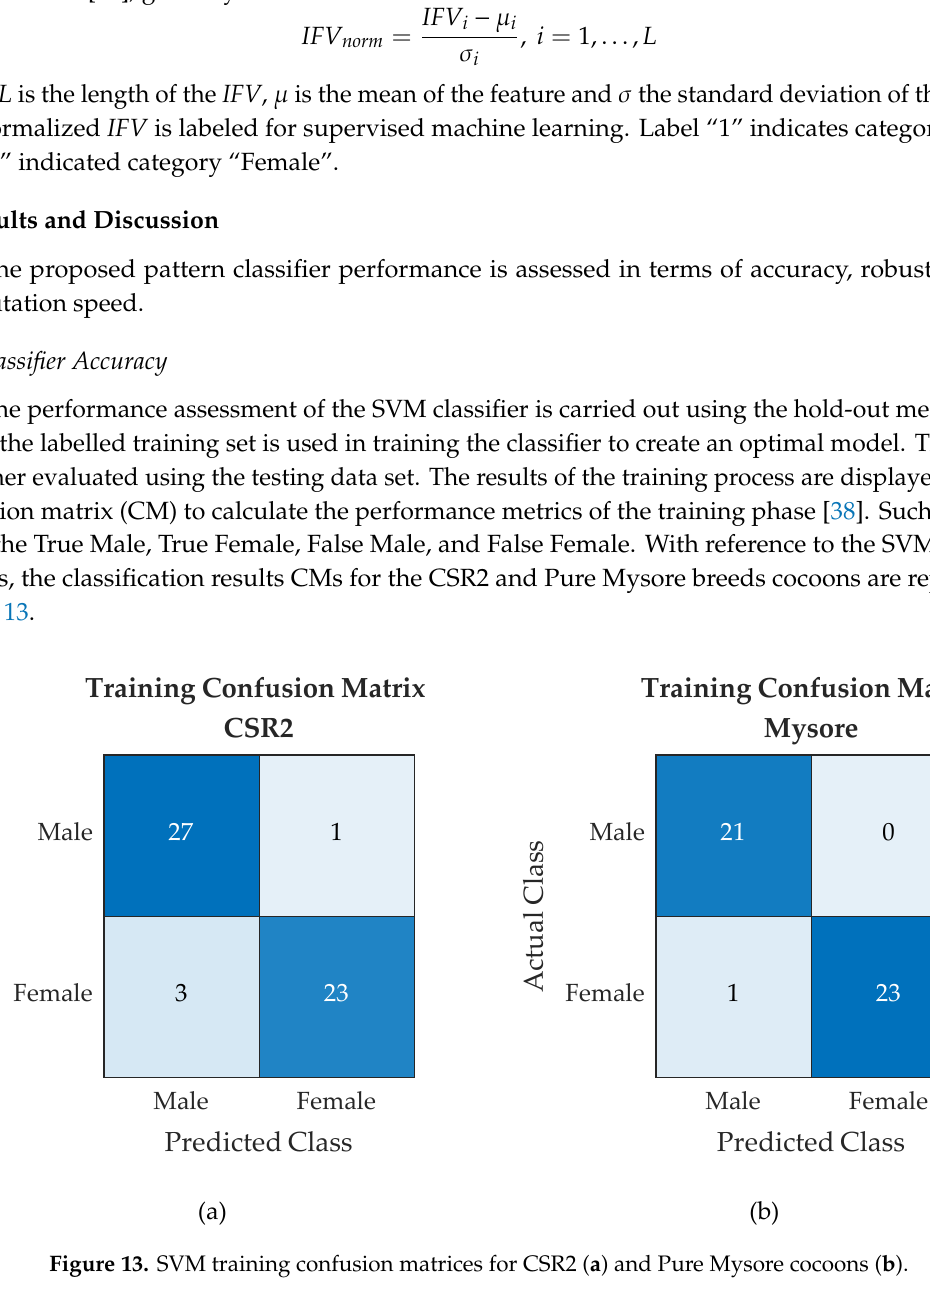
(b) Figure 14. SVM test confusion matrix for CSR2 cocoons ( a ) and Pure Mysore cocoons ( b ).